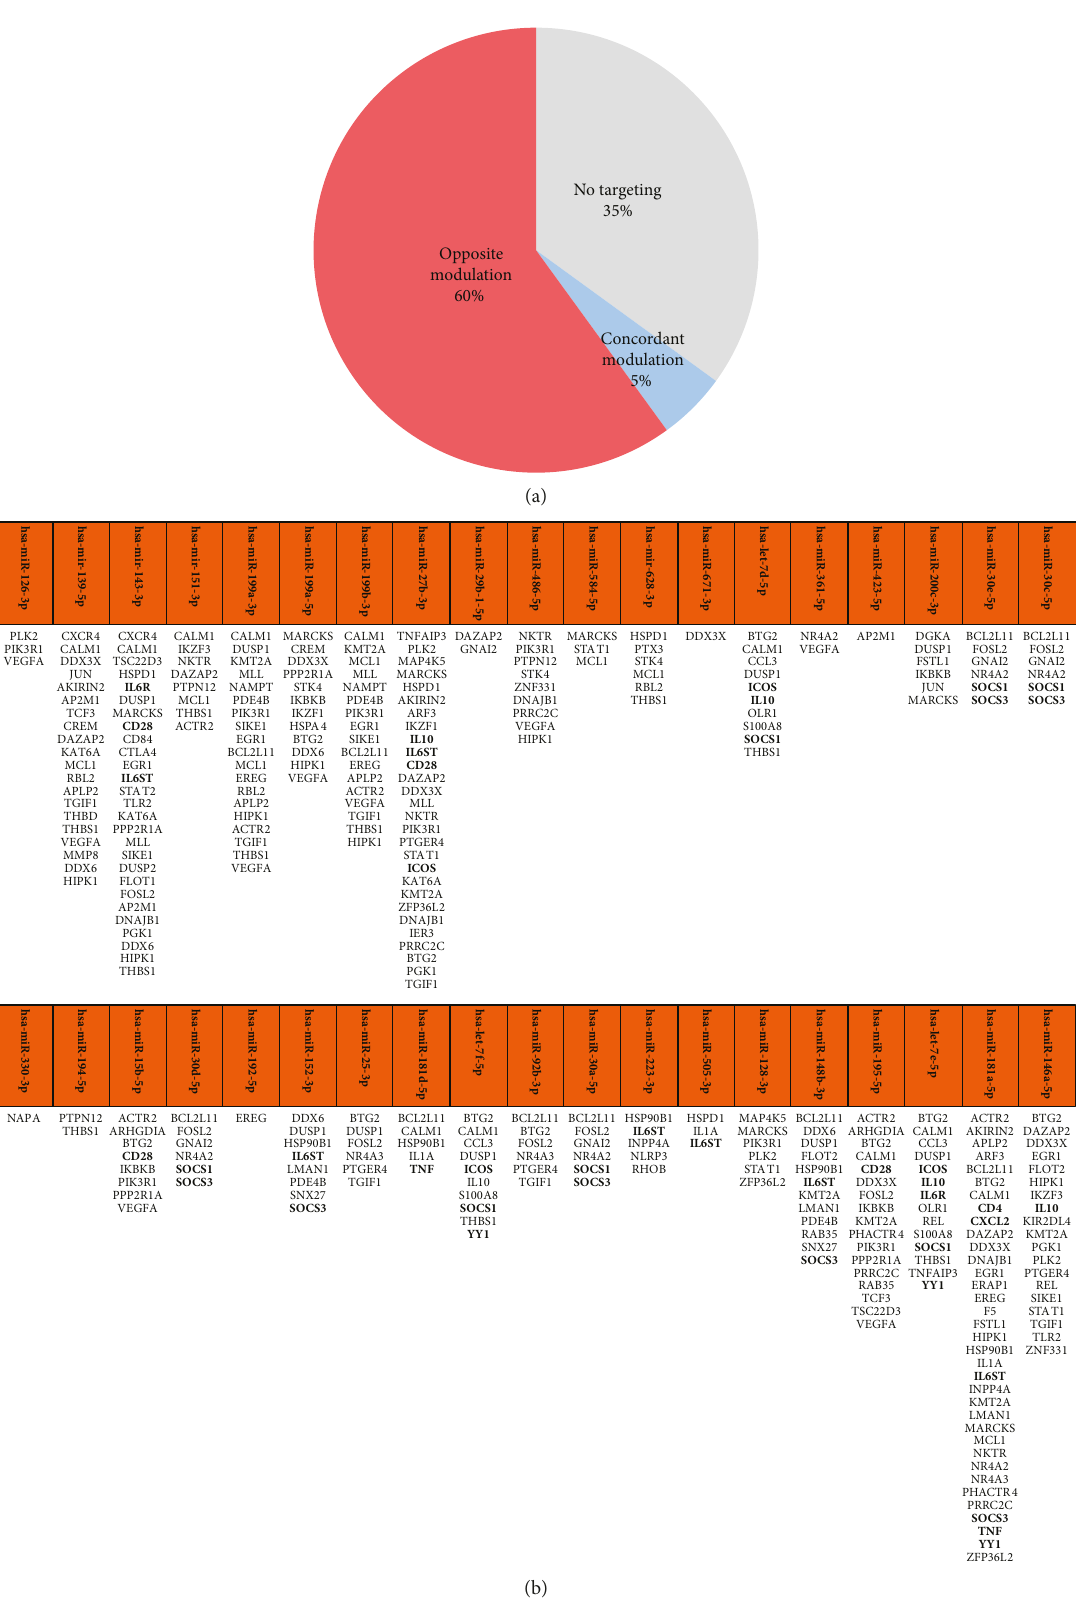
Figure 3: Selection of miRNAs that targeted genes di ff erentially expressed in BD. (a) Pie chart showing the percentage of BD DEGs that were targeted by miRNAs modulated in BD. (b) BD-modulated miRNAs and their respective targeted BD DEGs. Genes associated with Th17 cells are written in bold